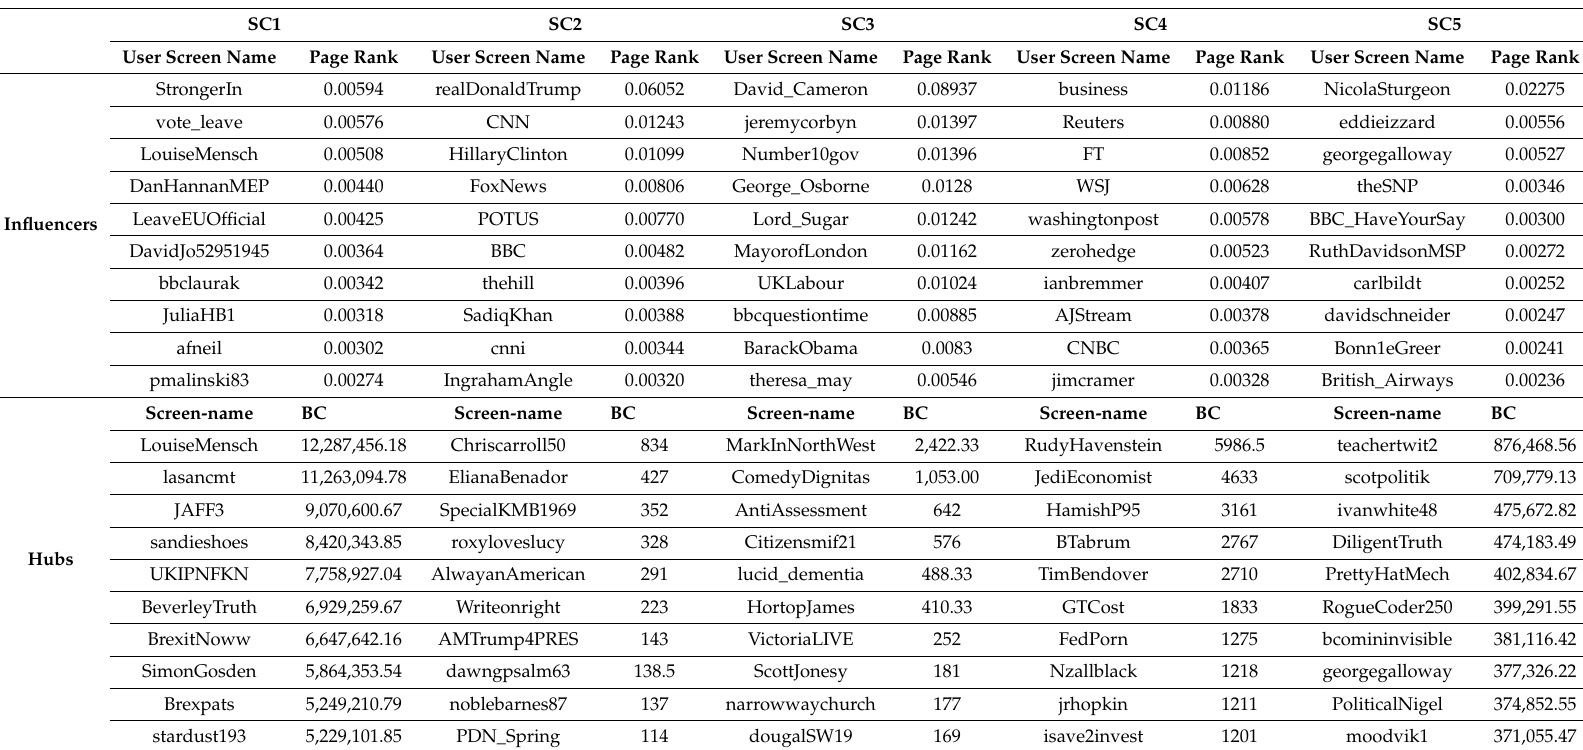
Table 6. Top 10 Influencers and Hubs in the Five Largest